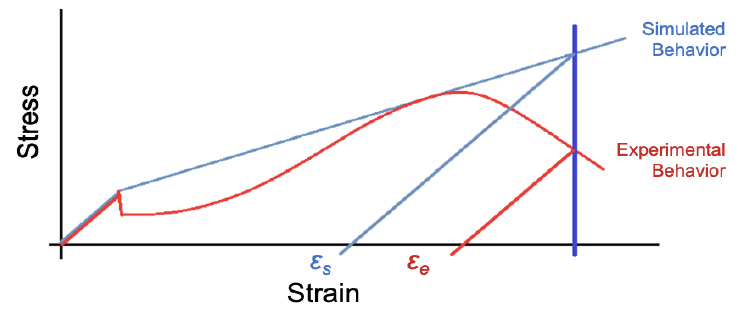
Figure 13. Experimental stress–strain curve discretization by linear trends, namely bilinear isotropic hardening.